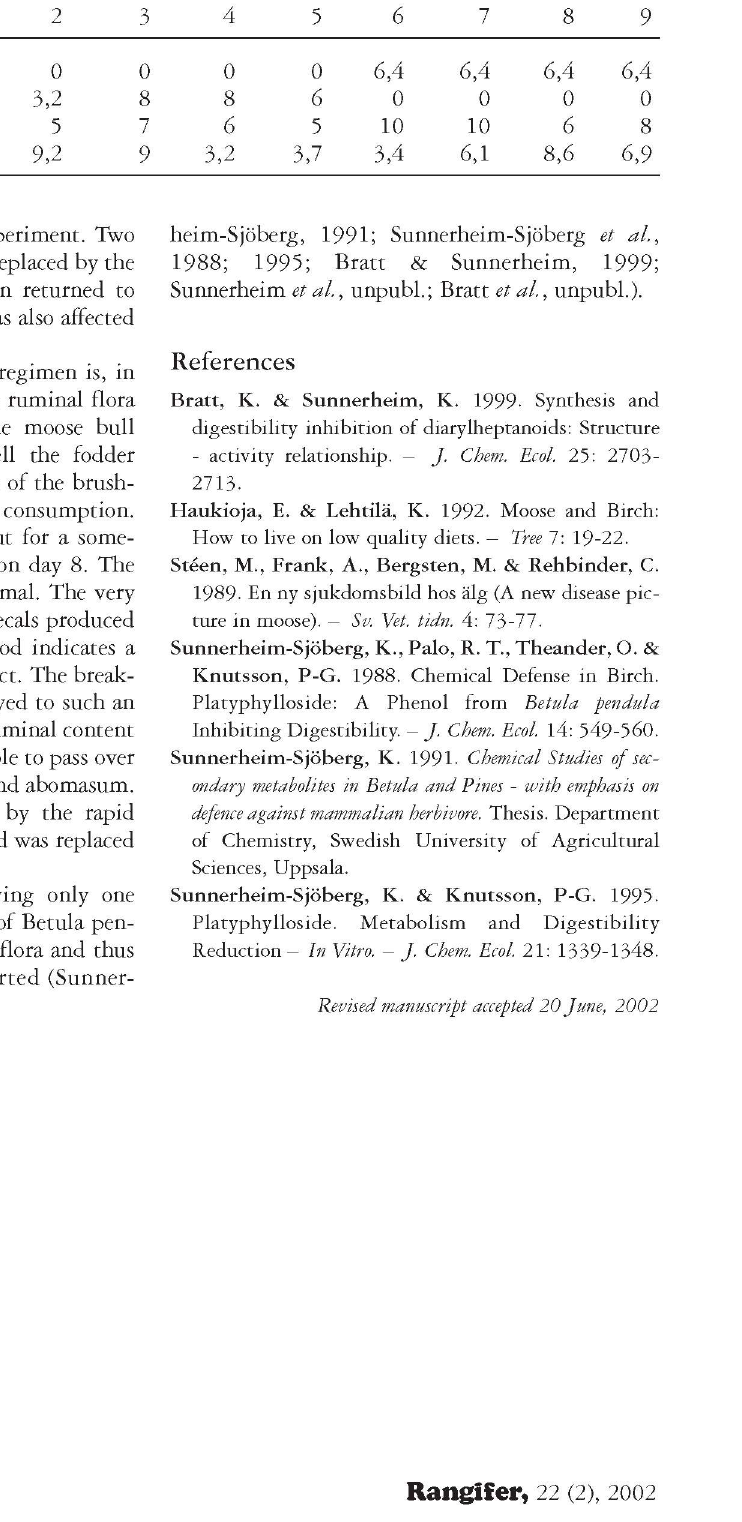
Table 1. Fodder, brushwood and water consumption along with faecal production per day. Day